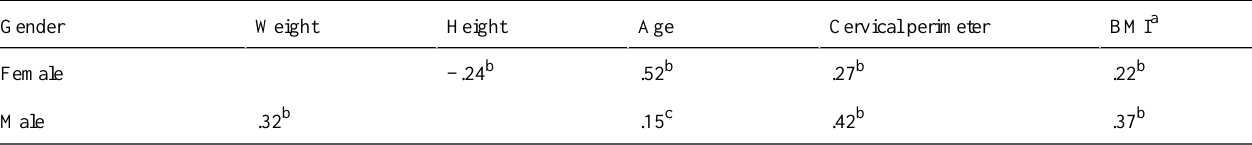
Table 2. Spearman correlations between clinical variables and apnea-hypopnea index (AHI) on the female (n=129) and male (n=254) population (for clarity, nonsignificant correlation values are omitted) .